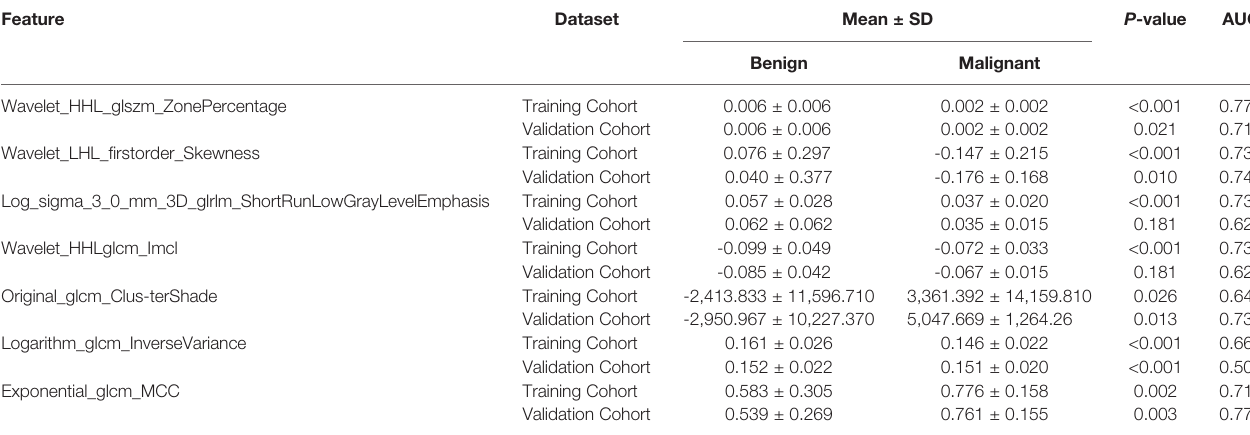
TABLE 3 | Diagnostic performance of the selected features for the diagnosis of breast lesions.